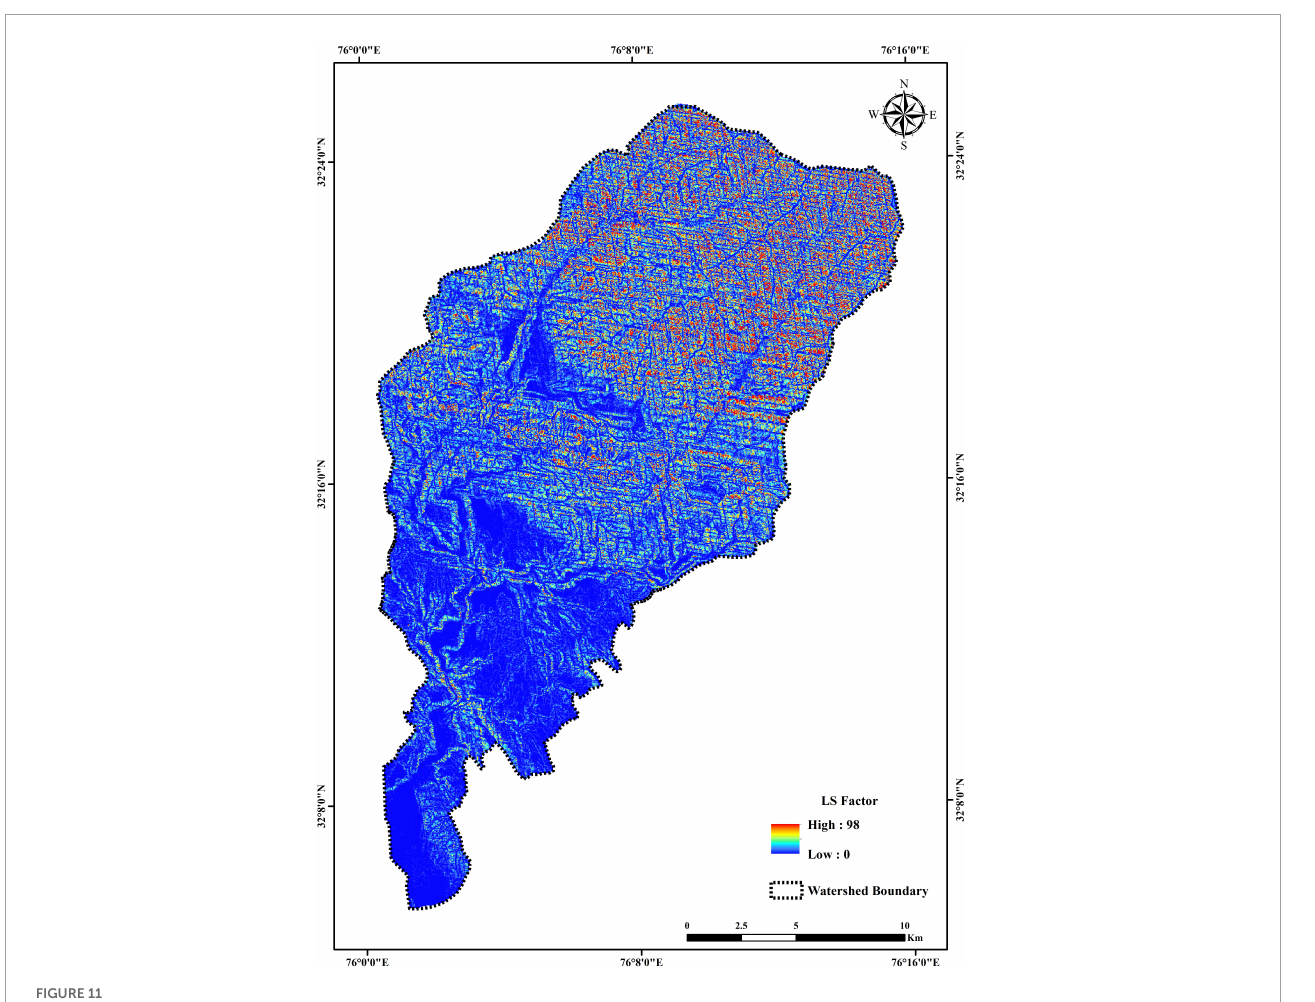
FIGURE11 Map showing LS factor of the Dehar watershed.